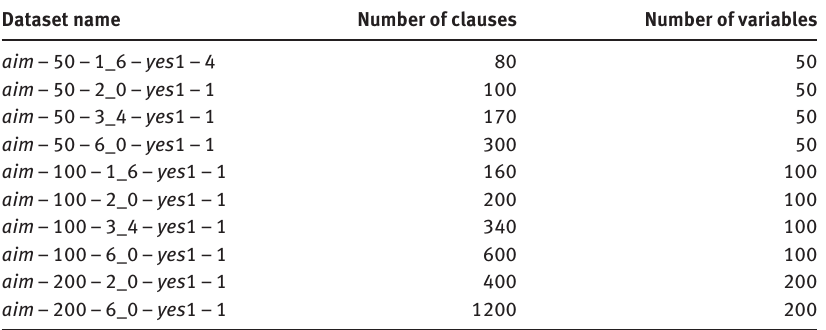
Table 1: The Characteristics of the Dataset used in the Evaluation. Dataset name